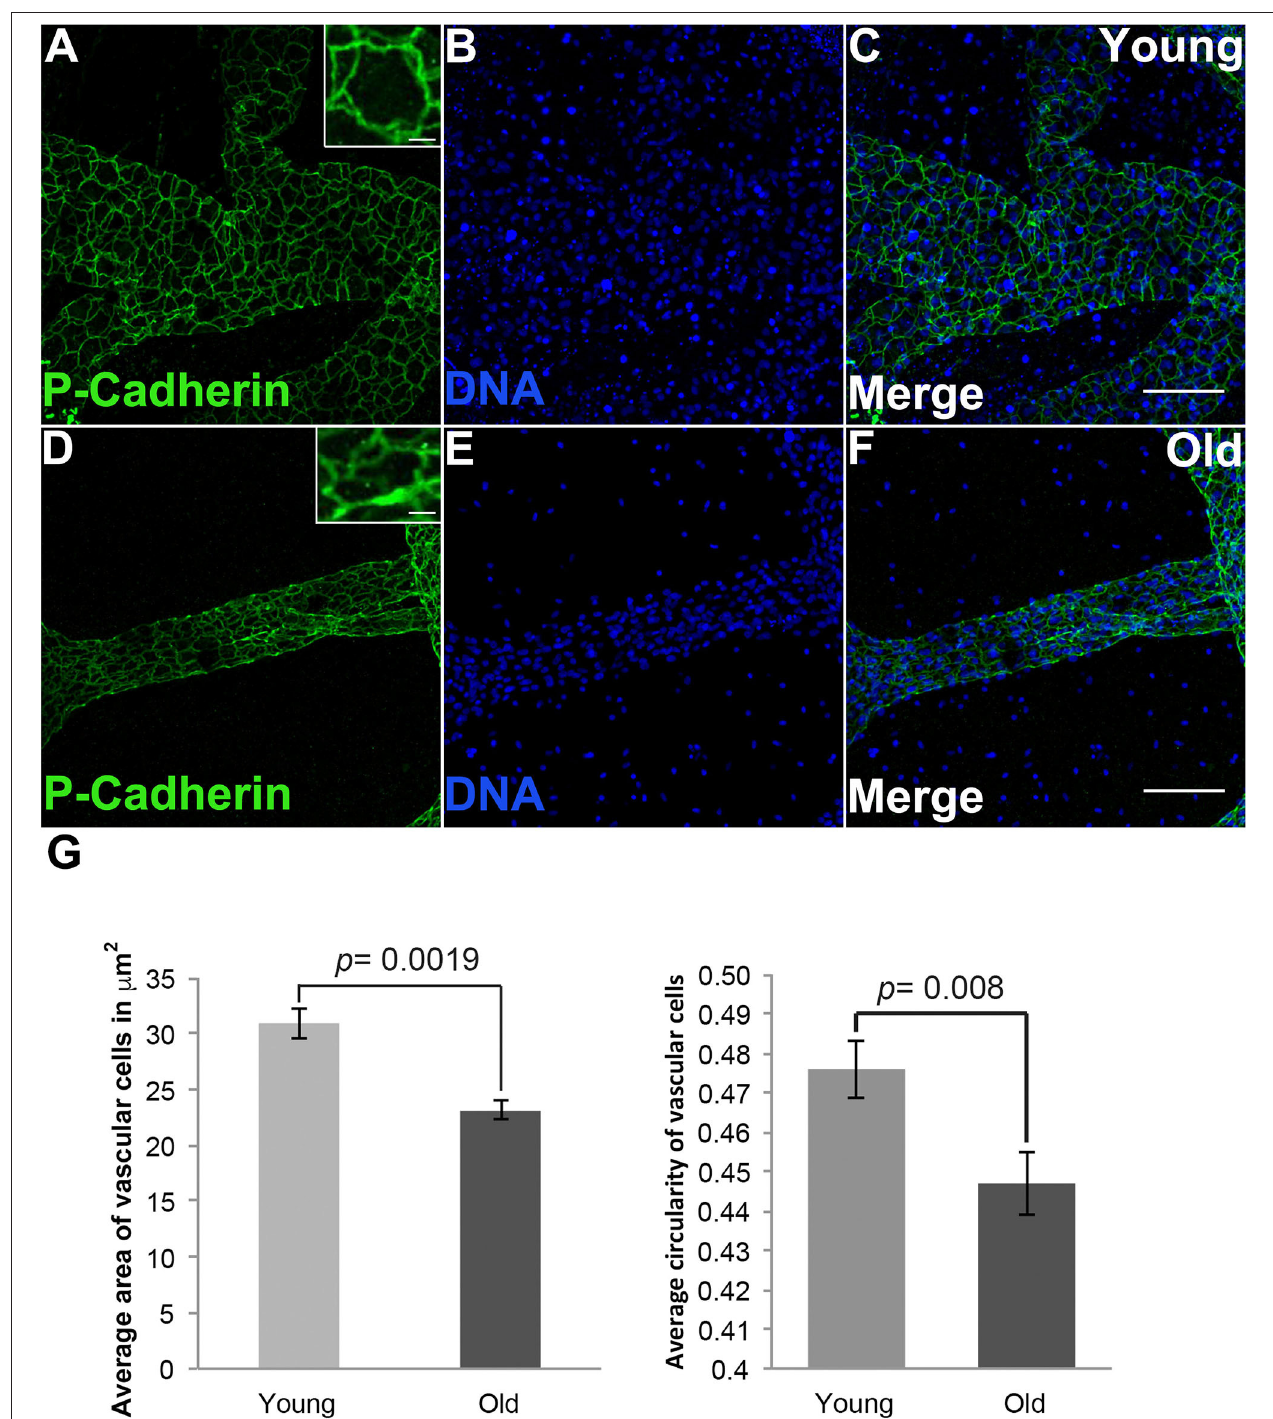
FIGURE 3 | Shape and size changes of aged vascular cells. (A–C) Young vessels contain cells that are round on average. (A) Representative images showing the cell boundaries, labeled via fluorescent immunostaining of Pan-Cadherin, in the blood vessels of young Botryllus colonies counterstained with Hoechst 33342 to visualize the cell nucleus [ (B,C) merged] (inset showing zoomed-in image of a single young cell). (D–F) Old vessels contain cells that are elongated (on the vessel long axis) on average. (D) Representative images showing the cell boundaries, labeled via fluorescent immunostaining of Pan-Cadherin, in the blood vessels of old Botryllus colonies counterstained with Hoechst 33342 [ (E,F) merged] (inset showing zoomed-image of a single old cell). (G) Average area in µ m 2 and circularity (where a value of 1 indicates a perfect circle) of both young and old cells found within the vessels. For clarity only circularity values ranging from 0.4 to 0.5 are shown. Statistical analysis was performed using the Student’s t -test. Scale bars: 50 and 5 µ m for insets on (A,D) .